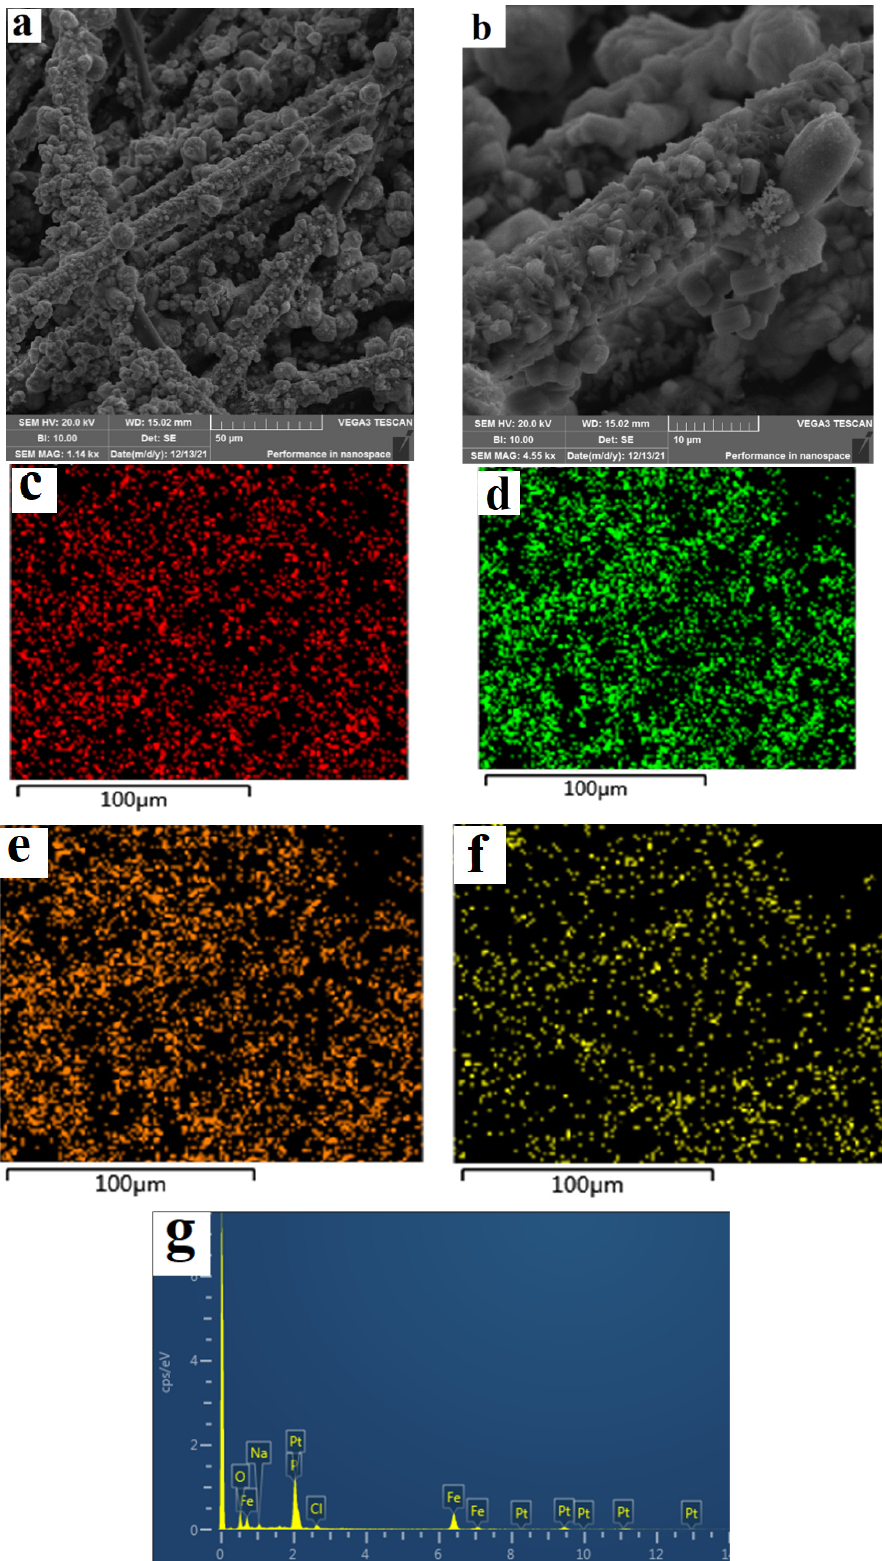
Figure 2. SEM images ( a,b ), edx mapping( c–f ) and EDX spectrum ( g ) of FeP-Pt/CC.